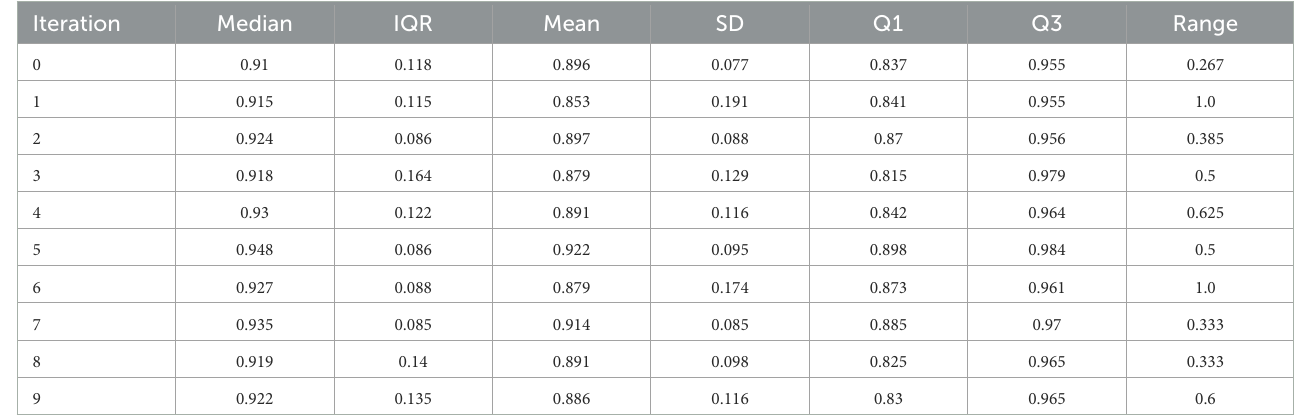
TABLE 3 Summary statistics of the IGP scores over 10 runs. Iteration